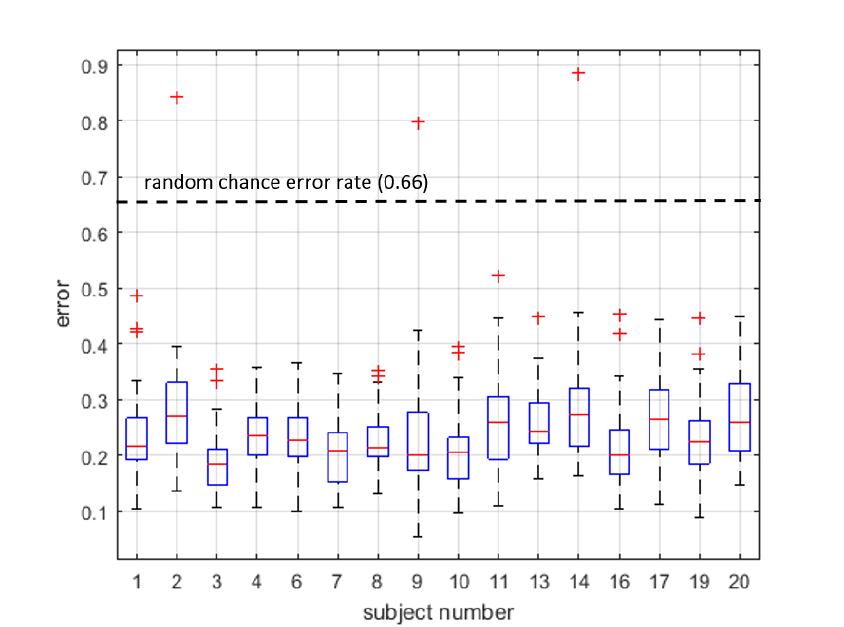
Figure 6. Comparison of classification error by subject for a five-component unigram HMM.